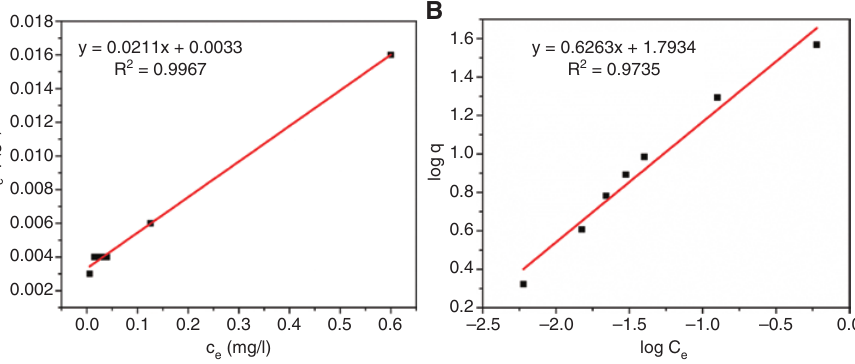
/q (g/l) on C (mg/l) of As(III) and (B) the dependence of logq on logC e e